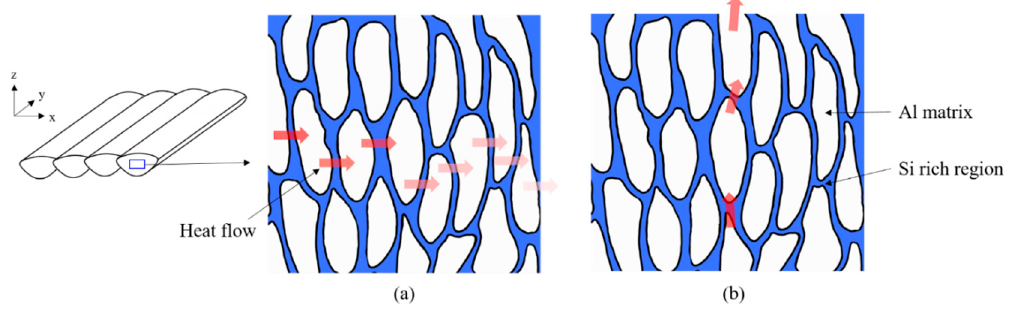
Figure 11. Example of heat flow through cells in melt pool core along ( a ) x-axis and ( b ) z-axis. At the boundary of the melt pool, there exists a coarse cellular zone consisting of cells, which have equiaxed structures and are coarser than cells inside the melt pool core. The heat affected zone (HAZ) also exists at the outside of the coarse cellular zone; the HAZ has a shape, in which the fibrous Si network is broken into particles [19]. From these structural characteristics, it can be expected that the high thermal conductivity of the Al matrix is more effective at the melt pool interface than in the melt pool core region.